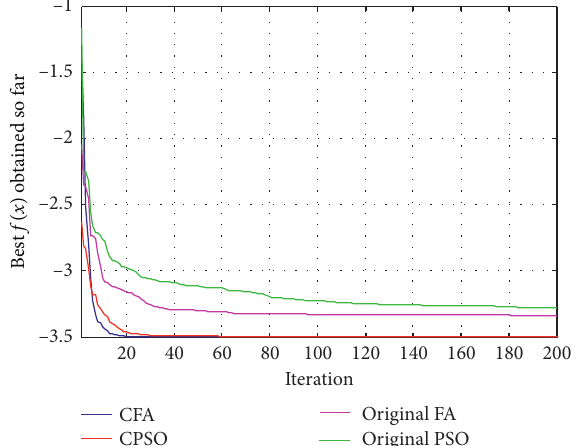
Figure 3: The convergence curve of the best f ( x ) obtained so far by original PSO, original FA, CPSO, and CFA for problem 2.